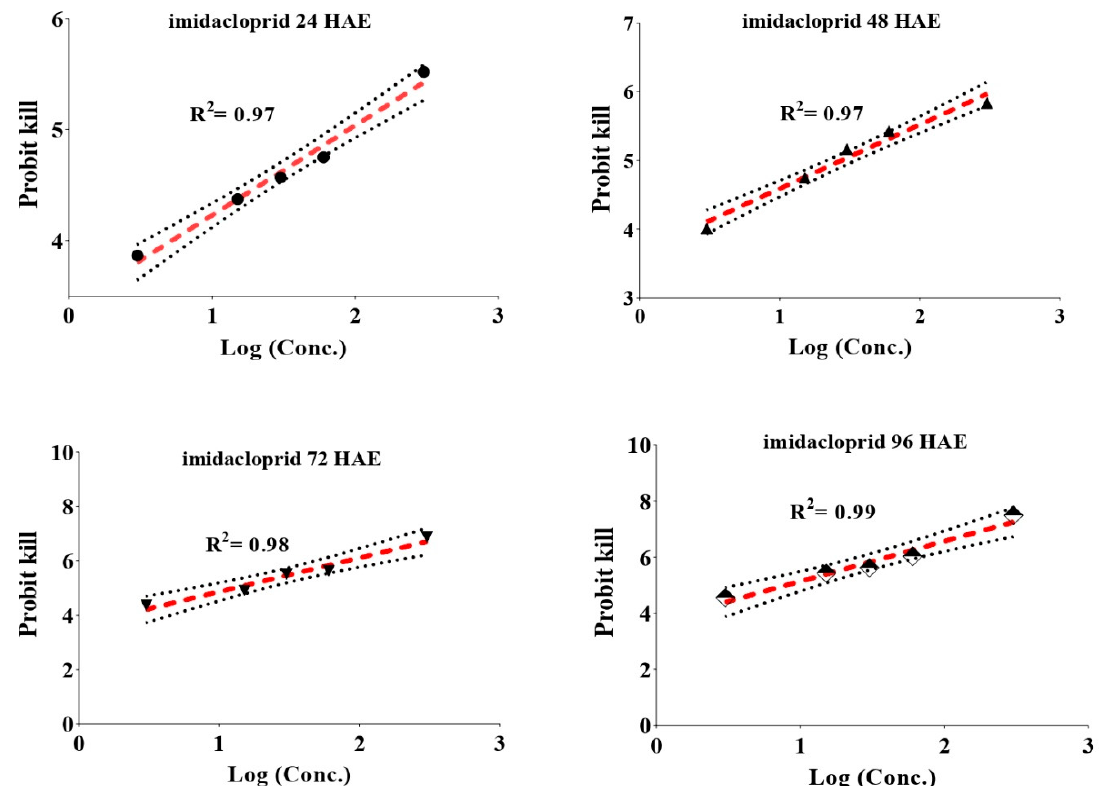
Figure 1. Concentration mortality response of imidacloprid against whitefly adults. The straight line represents the best fitting probit regression line between insecticide log dose and mortality probits (working probits) for adult B. tabaci at different intervals of time after the insecticide exposure, slopes of the lines are given in the Table 2. The arched line represents the standard error (SE) for the slope of straight regression